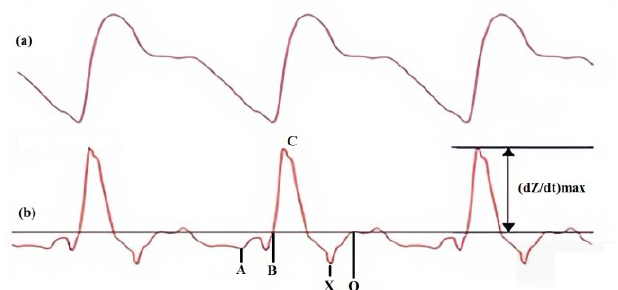
Fig. 2. (a) The top plot represents the bioimpedance signal (ΔZ) (change in impedance over time). (b) The bottom plot represents the ICG signal